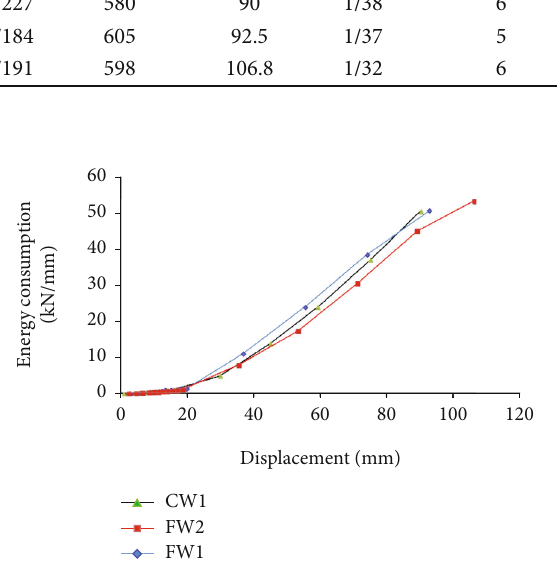
Figure 10: Cumulative energy dissipation of